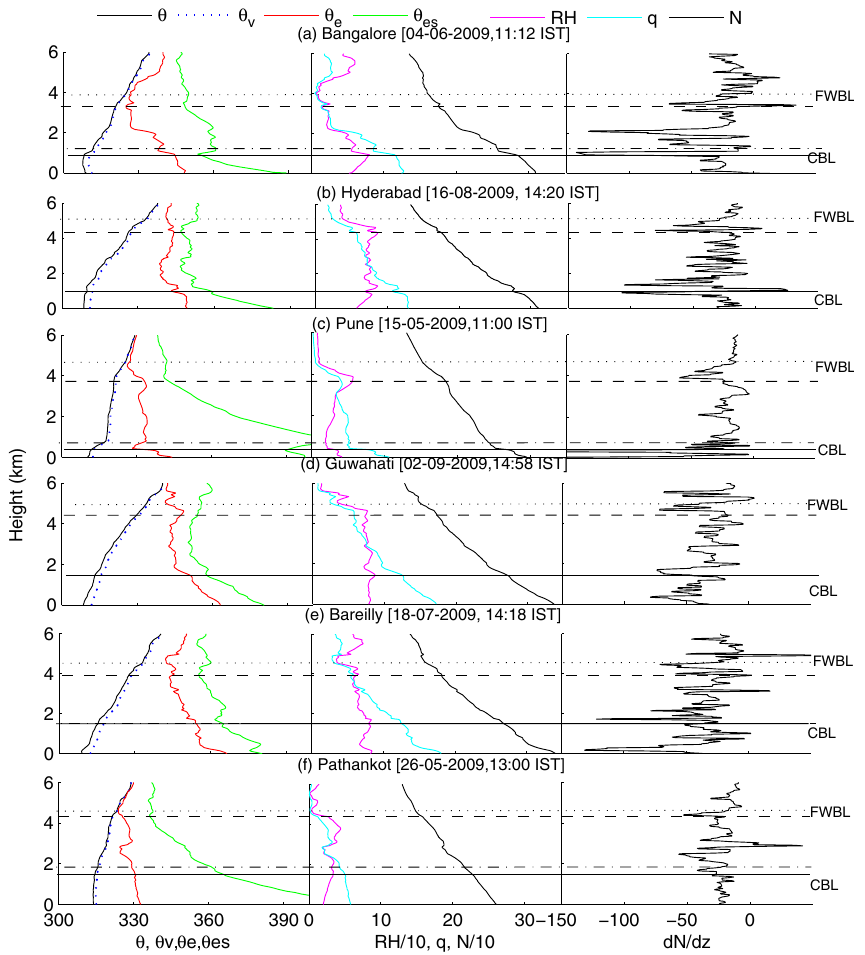
Figure 4. The vertical profiles of potential temperature ( θ ), virtual potential temperature ( θ v ), equivalent potential temperature ( θ e ), saturated equivalent potential temperature ( θ es ), relative humidity (RH), specific humidity ( q ), refractivity ( N ), and refractivity gradient observed over (a) Bangalore, (b) Hyderabad, (c) Pune, (d) Guwahati, (e) Bareilly, and (f) Pathankot indicating the convective boundary layer (CBL) and the fair-weather boundary layer (FWBL) during the Indian summer monsoon season (JJAS) in 2009. Solid and dashed-dotted lines represent the bottom and top of the CBL, respectively, and dashed and dotted lines represent the bottom and top of the FWBL,